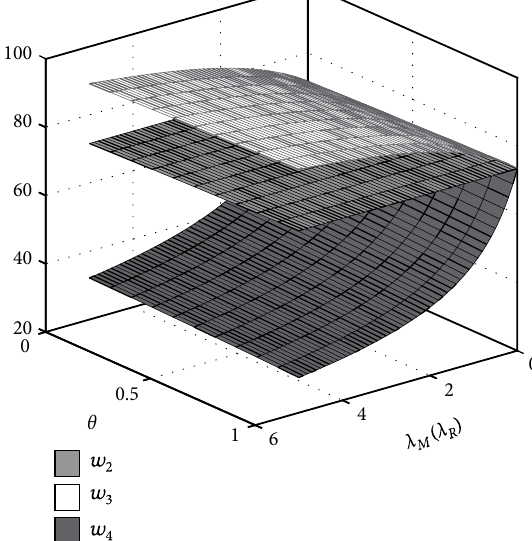
Figure 2: The effect of 𝜃 , 𝜆